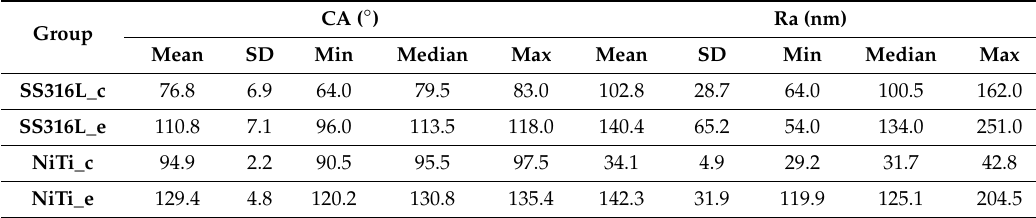
Figure 3. Contact angle ( a ) and Ra ( b ) measurements of experimental and control surfaces. Table 1. Values for contact angle (CA) and roughness (Ra).